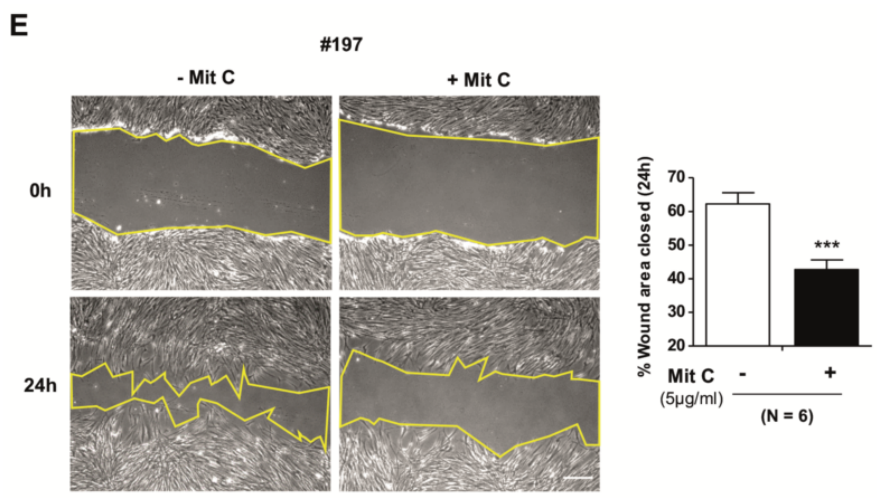
Figure 4. Effect of IL-1 β on repair-associated processes in primary pulmonary fibroblasts. ( A ) An in vitro scratch assay was performed to measure the effect of IL-1 β in fibroblasts motility. Percentage of the total wound area closed by fibroblasts after 24 h with or without IL-1 β (10 ng/mL). Representative images of the wound formed after the scratch (time 0 h) and 24 h after, with or without IL-1 β . The dashed yellow lines show the edges of the wound. Scale bar, 100 μ m. ( B ) Fold fibroblast migration through a transwell insert with or without IL-1 β (10 ng/mL) in the lower compartment of the well. Representative images of migrating cells are shown at the top. ( C ) Effect of IL-1 β (10 ng/mL) in fibroblast cell density. Fibroblasts were cultured with or without IL-1 β for 72 h, and cell numbers were determined by counting nuclei stained with DAPI. The horizontal dashed line corresponds to the untreated fold expression (ratio = 1). ( D ) Fibroblast proliferation under IL-1 β was evaluated by using the Click-iT Edu flow cytometry assay kit. Results are shown as % of Click-it + cells (proliferating cells) with respect to total cells. ( E ) Effect of proliferation inhibition in fibroblasts abilities to close a gap in a scratch assay, which was performed as in ( A ) by adding the proliferation inhibitor Mitomycin C (5 μ g/mL) (Mit C) after wounding. Representative images at 0 and after 24 h with/without Mit C are shown on the Left, Scale bar as in ( A ). Quantification of the percentage of the total wound area closed is shown on the Right. Statistical analysis as in Figure 1, * p < 0.05, ** p < 0.01, *** p < 0.005.